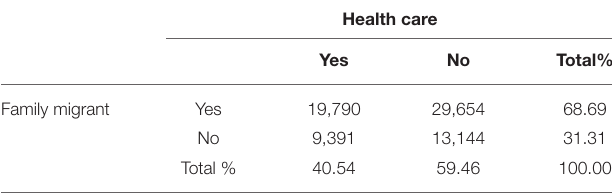
TABLE 5 | Health insurance coverage of family migrants in China ( N =